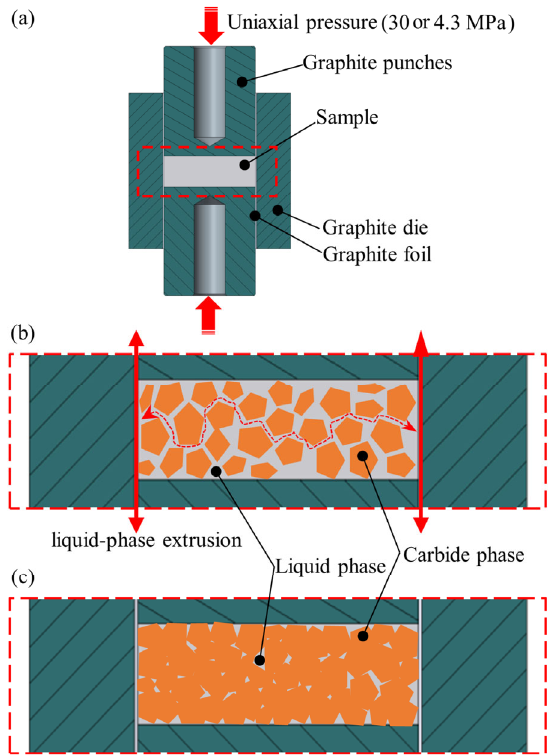
Fig. 8 Schematic illustration showing the Co-based liquid-phase extrusion mechanism: (a) mold components; (b) during sintering and (c) after